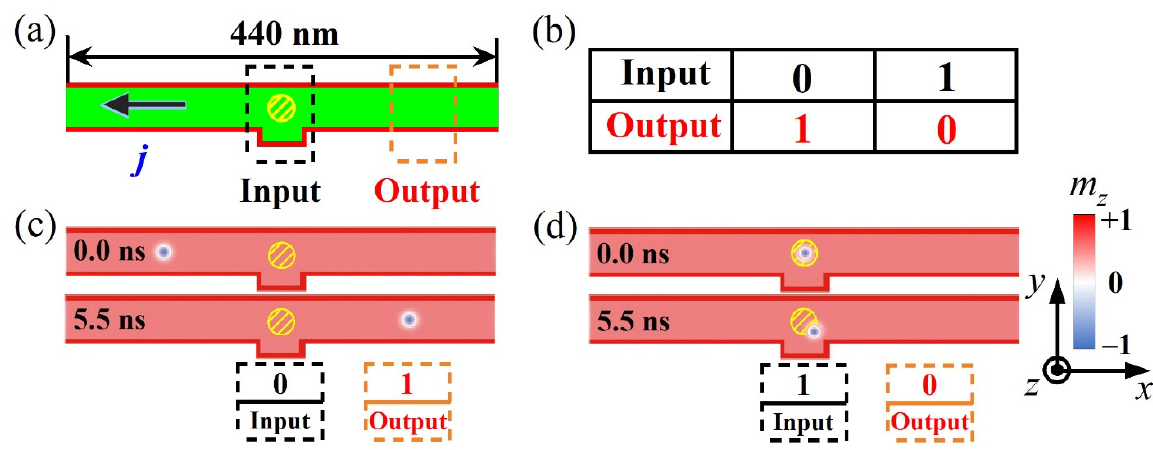
Figure 5. Layout for logic device and logic NOT operation. ( a ) Sketch of logic device consisting of ‘Input’, and ‘Output’ regions. ( b ) The table for the logic NOT operations. ( c , d ) The moving isolated skyrmion in the nanotrack achieves the operations of 0 → 1 and 1 → 0. All the operations are carried out under constant K c = 0.7 MJ/m 3 and spin current density j = 20 MA/cm 2 . Here the diameter of the circle-shaped capping nano-island in the ‘Input’ region is 25 nm.